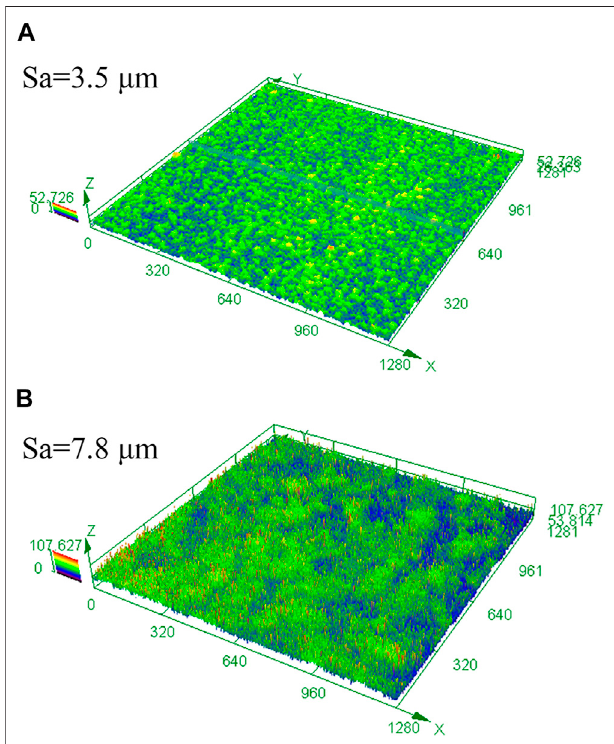
FIGURE 11 | 3D image and surface roughness of HP-13Cr SS after LA immersion. (A) 95 ° C/2.8 MPa and (B) 120 ° C/3.2 MPa.